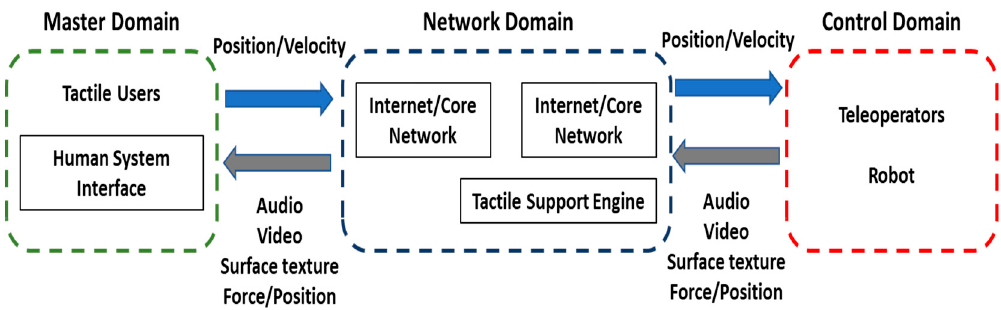
Figure 14. A generalized architecture of a wireless tactile internet system (adapted from [60]).